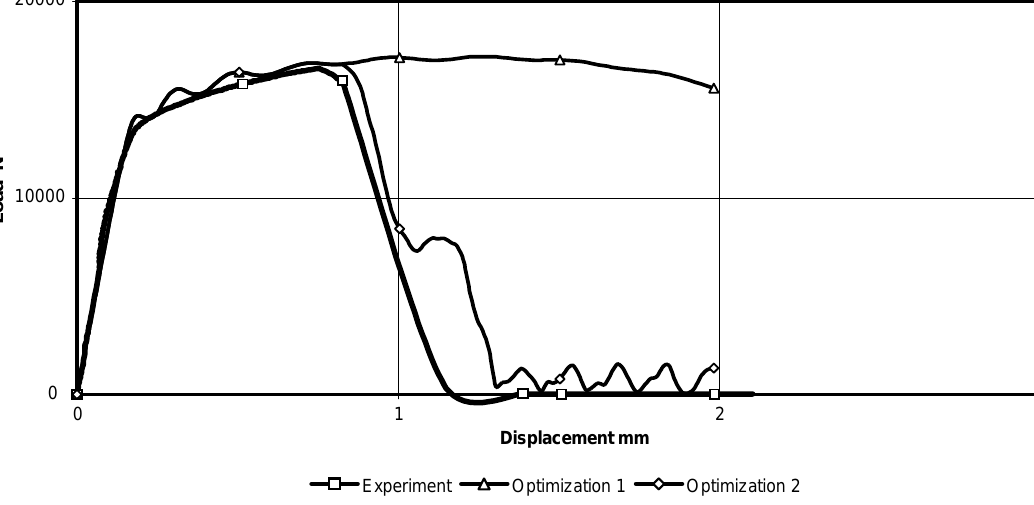
Fig. 9. Comparison of experimental and numerical results – Second optimization – (Punched tension specimens – 2024-T351 aluminium alloy). gram is based on the conjugate gradient method